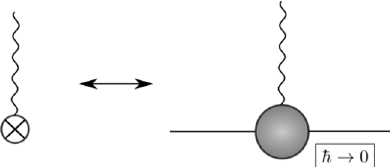
Figure 1. Equivalence between point-particle backgrounds and the 3-pt function with an off-shell coherent